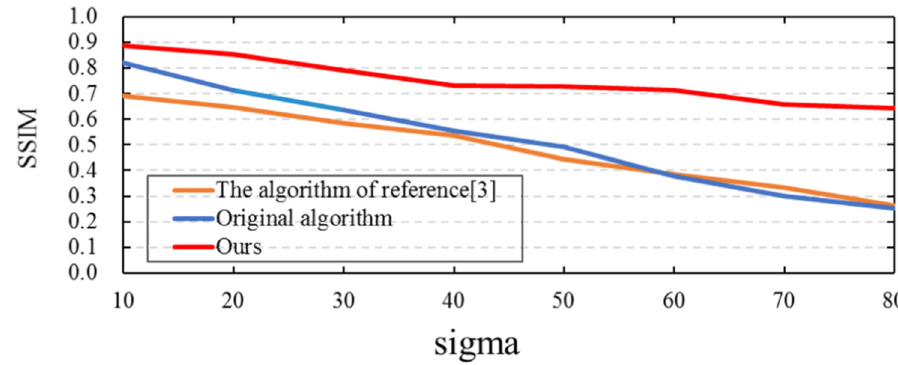
Figure 12. SSIM line chart of the three algorithms for the MIT image.